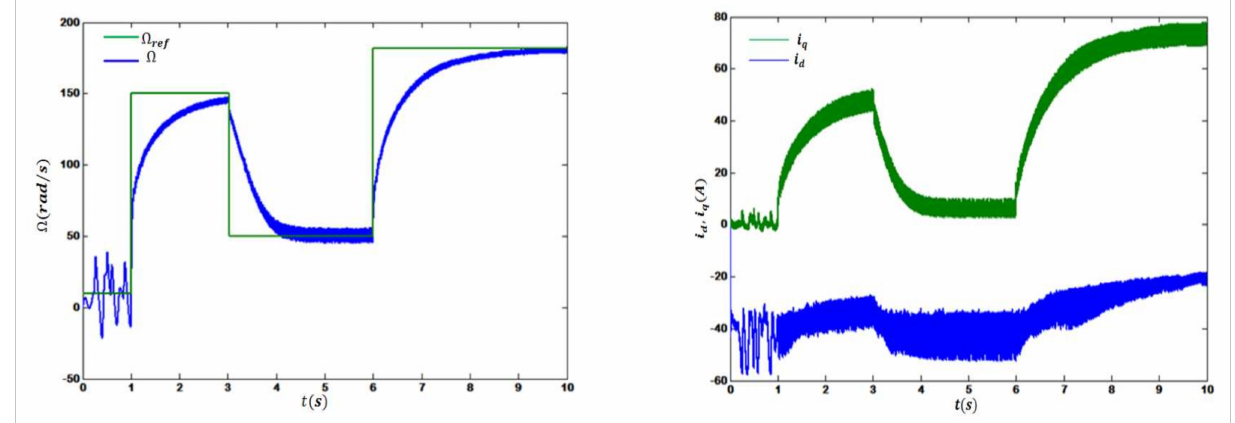
Figure 13. PMSM performance for different reference speed ω ref = 10, 150 and 180 rad/s, for the operating point OP 2 , and for T = 25 ◦ C.